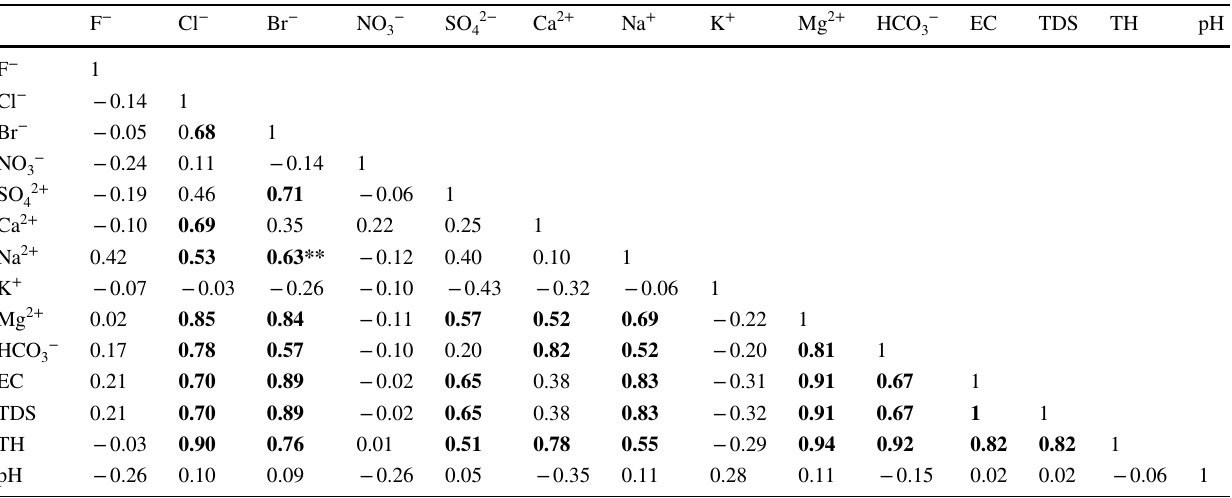
Table 3 Pearson correlation coefficients for 14 hydrogeochemical parameters of groundwater samples of Gergera watershed